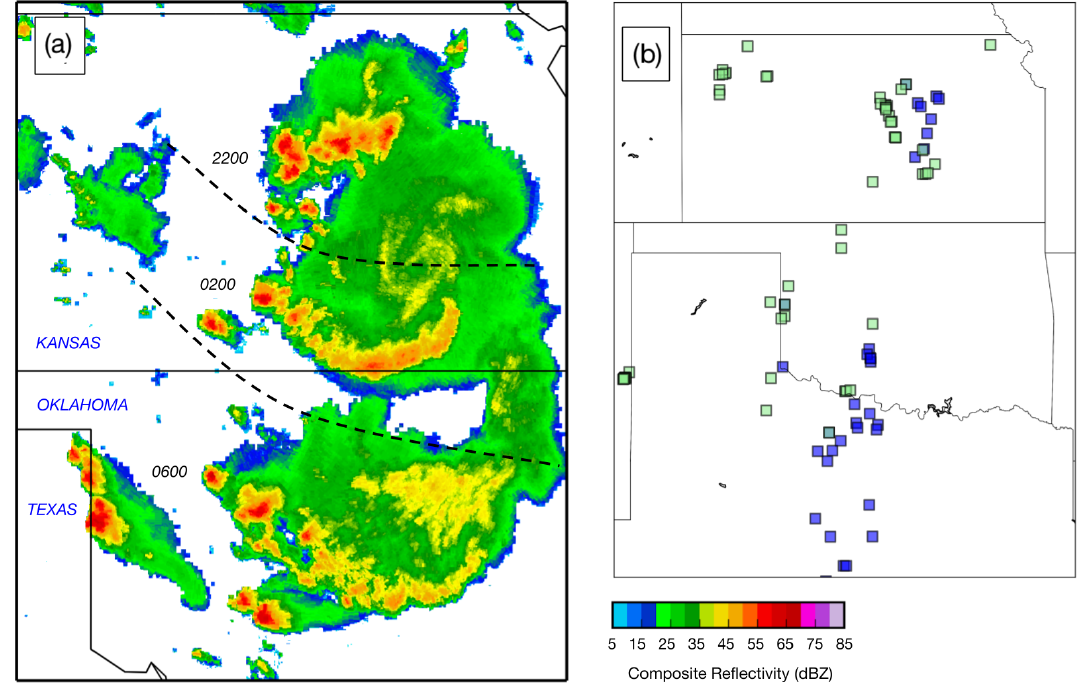
Figure 1. Overview of the bowing MCS of interest: ( a ) time-composited image of observed composite radar reflectivity at three times (2200UTC Day 1, 0200UTC Day 2, and 0600UTC Day 2), as the system moved south. Dashed lines roughly delineate the three times from which reflectivity is drawn; and ( b ) National Centers for Environmental Information storm data for all wind reports exceeding 25ms − 1 (50kt; in blue) and hail reports exceeding 2.54cm (1in; in